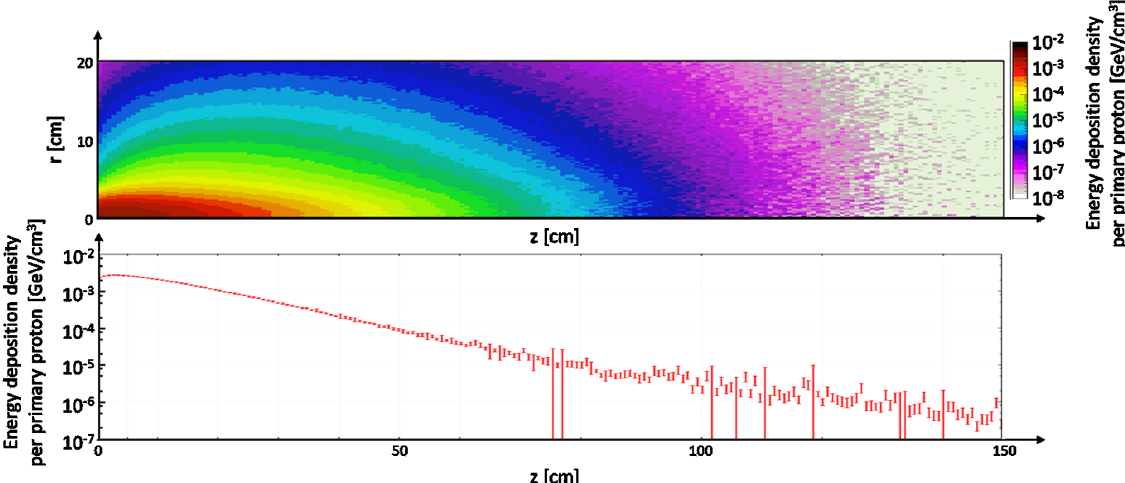
FIG. 9. Top: energy deposition density (GeV = cm 3 per primary proton) deposited into the dump core by the 2 GeV NORMGPS beam. Bottom: corresponding maximum value of the energy deposition density along the length of the dump